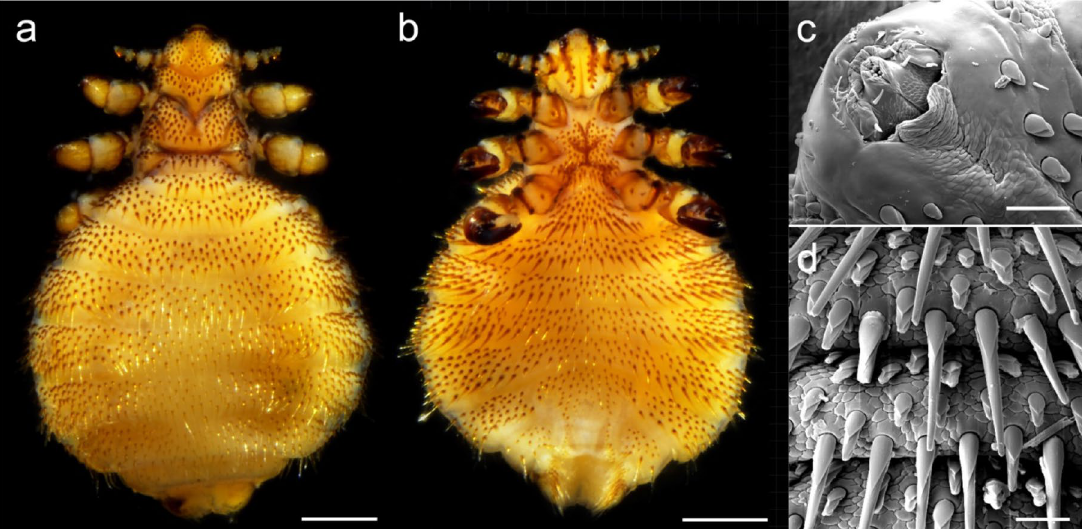
Figure 1. Stereomicroscopic and scanning electron microscopic (SEM) images of the seal louse, Echinophthirius horridus . ( a ) Dorsal and ( b ) ventral view of the heavily infected female louse with a plump gravid abdominal area. ( c ) Eversible proboscis evolved for haematophagous life style. ( d ) Modified setae as sensorial organs located on the cuticular. Scale bars: ( a , b ) 500 µm, ( c , d ) 50